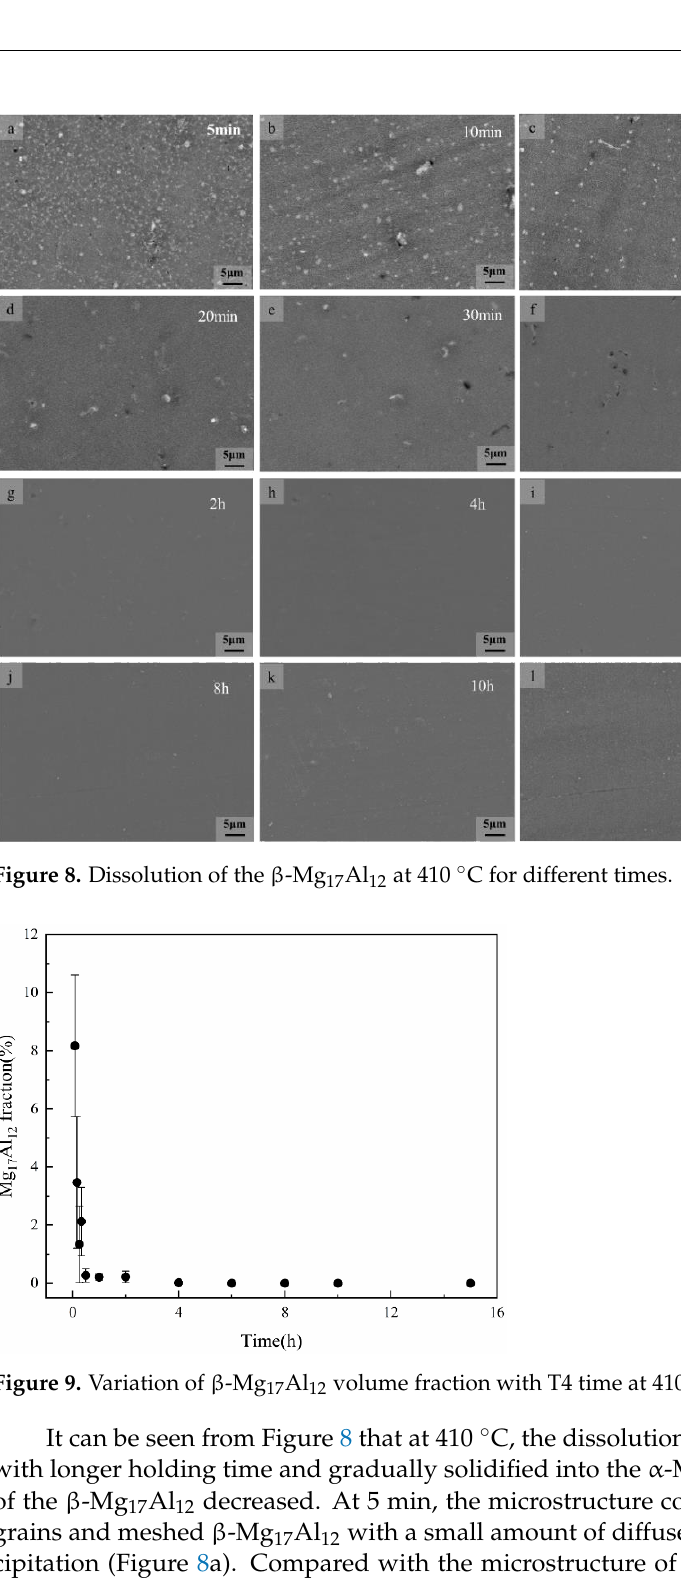
11 of 17 Figure 7. Fracture morphology at different T4 temperatures: ( a – c ) 330 °C; ( d – f ) 410 °C. 3.6. Mechanism of the β -Mg 17 Al 12 Dissolution From the previous results, it is known that the β -Mg 17 Al 12 in SLMed AZ61 magne- sium alloy decomposes completely at 410 °C for 2 h. In order to further investigate the